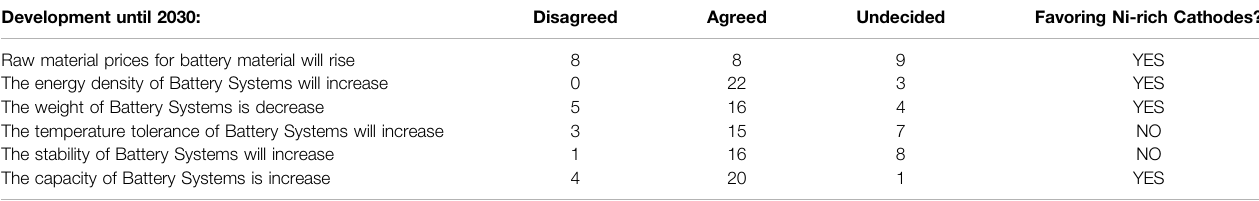
Table 1 | Statements on battery developments and expert answers. Development until 2030: